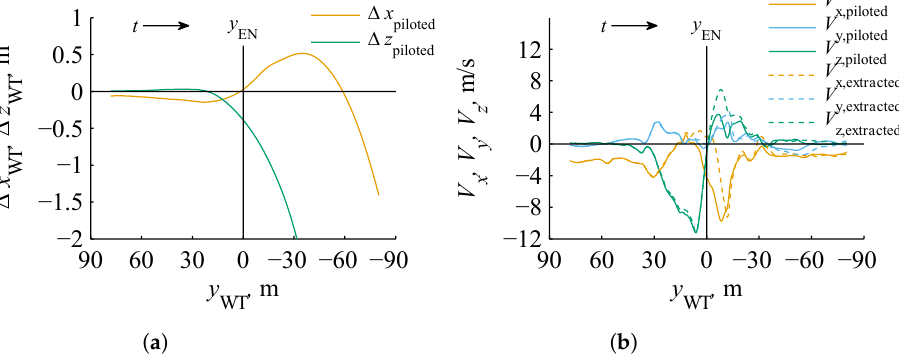
Figure 21. Comparison of flight path and airwake velocities between piloted simulations and an extracted ideal, straight-line flight path (Pilot A, position 5, V W = 11.3m/s). ( a ) Flight path deviations ( ∆ x piloted , ∆ z piloted ). ( b ) Airwake velocities ( V x , V y , V z ).